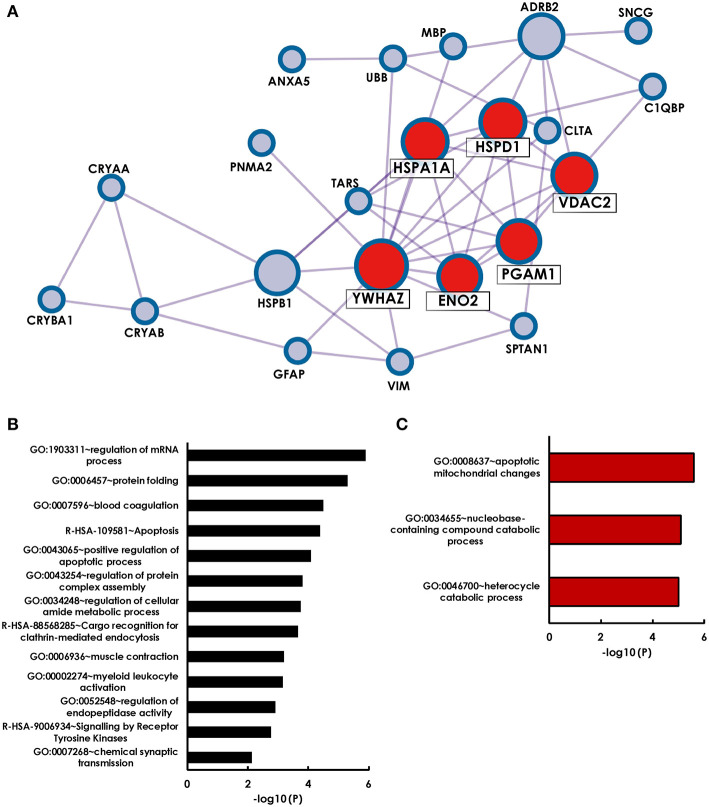
Holistic bioinformatics analysis of previously established glaucoma-related autoantigens. (A) Protein-protein interaction network. Twenty-two of the twenty-eight glaucoma-related antigens have at least one interaction partner among each other. Especially strong interactions were observed for six antigens (HSPA1A, HSPD1, YWHAZ, VDAC2, PGAM1, ENO2), that were identified by the Metaspcape algorithm MCODE (marked with red spots). (B) GO analysis of 28 glaucoma-related antigens. Shown are significantly enriched GO terms of biological processes and reactome gene sets. (C) GO analysis of MCODE cluster antigens only.